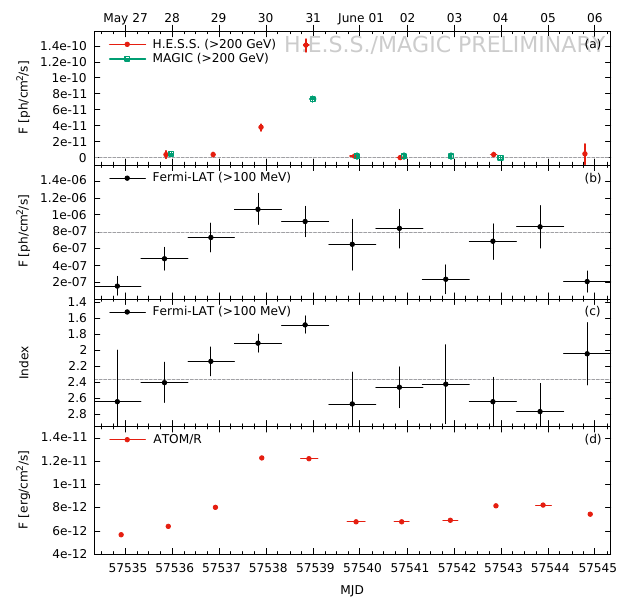
Figure 5. ( a ) VHE lightcurve obtained with H.E.S.S. (red) and MAGIC (green) for E > 200GeV in nightly bins. The dashed line marks the zero flux level. ( b ) HE lightcurve obtained with Fermi -LAT for E > 100MeV in daily bins centered on the H.E.S.S. observation window. The dashed line marks the long-term average. ( c ) HE γ -ray spectral index from Fermi -LAT observations. The dashed line marks the long-term average. ( d ) Optical R-band lightcurve obtained with ATOM in nightly bins. In all panels only statistical errors are shown.